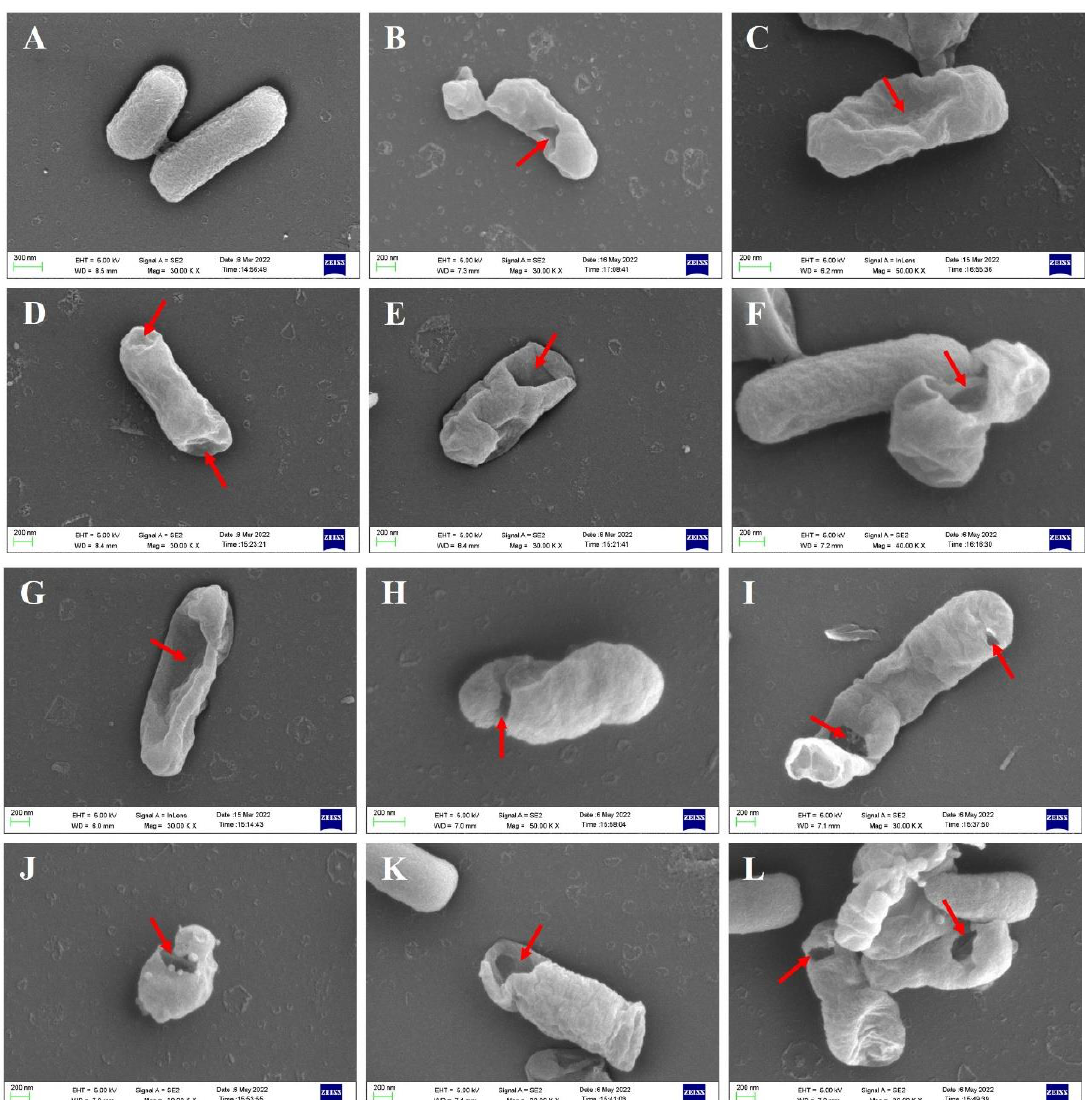
Figure 3. Morphological Observation of E. coli BL21(DE3) BGs by SEM. ( A ): Intact morphology of wild-type E. coli BL21(DE3); ( B , C ): E. coli BL21(DE3) ghost formed after lysis induced by plasmid pBV220- φX174 -E; ( D – F ): E. coli BL21(DE3) ghost formed after lysis induced by plasmid pBV220-ID52-E; ( G – L ): E. coli BL21(DE3) ghost formed after lysis induced by plasmid araC-ParaBAD-ID52-E. The red arrow indicates the transmembrane tunnels. TEM images manifested that the untreated wild-type E. coli BL21(DE3) showed